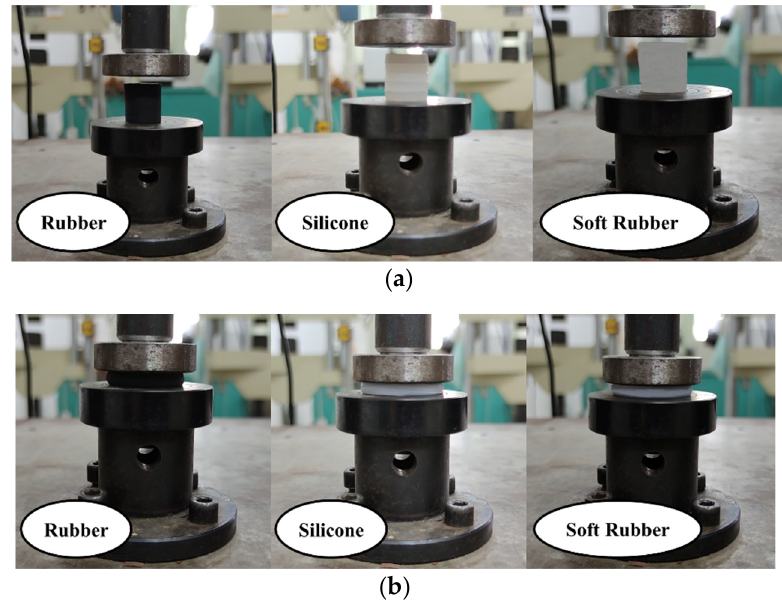
Figure 1. Uniaxial compression test: ( a ) before compression; ( b ) after Compression.